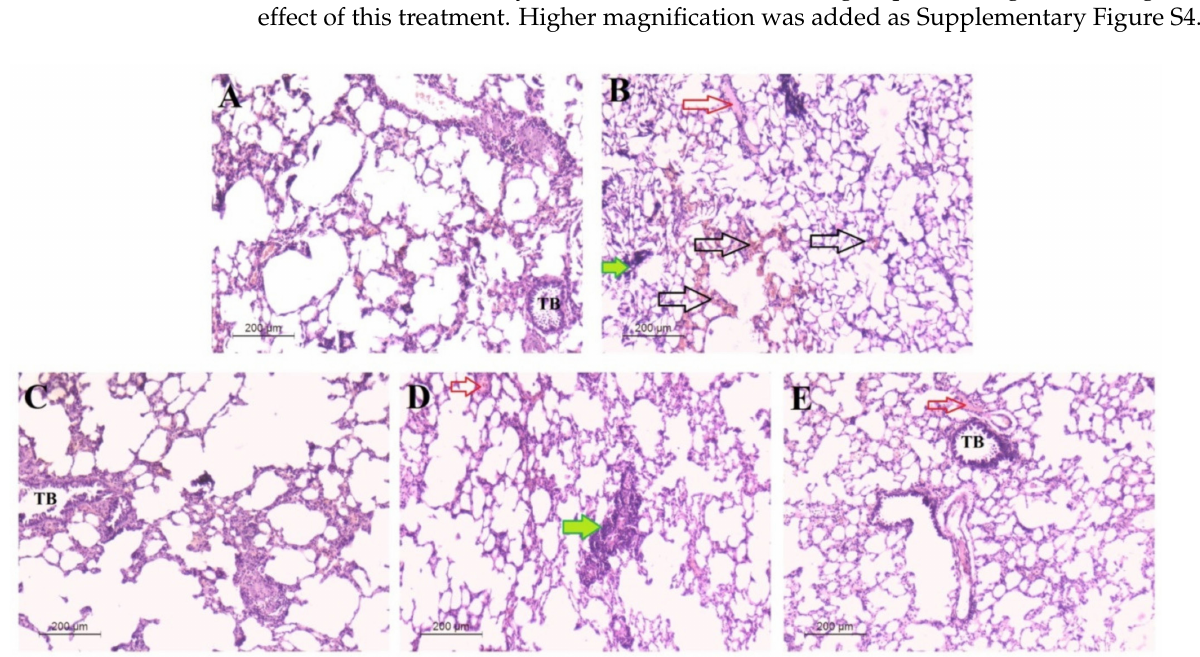
Figure 14. Photomicrograph of rat lung infected withKp5 and given endotracheal aerosolization various preparations of 1,2,3-triazole-sulphadiazine-ZnO hybrids as treatments, 96 h post-infection. ( A ) Negative control group. ( B ) Positive control; ( C ) 3c -ZnO; ( D ) 3a -ZnO; and ( E ) 3b -ZnO. Black arrows refer to increased macrophage focal accumulations in ( B ), with some remnants of macrophage accumulation only observed in ( D ); red arrows refer to the appearance of normal small blood vessels for gas exchange; green arrows refer to lymphatic-associated lymphoid tissue in ( B , C ) that is not symptoms of alveolar histiocytosis found in ( C , D ). Fewer signs of histiocytosis persisted in ( E ) with its elimination in ( A , B ). H&E stain (magnification: 200 ×